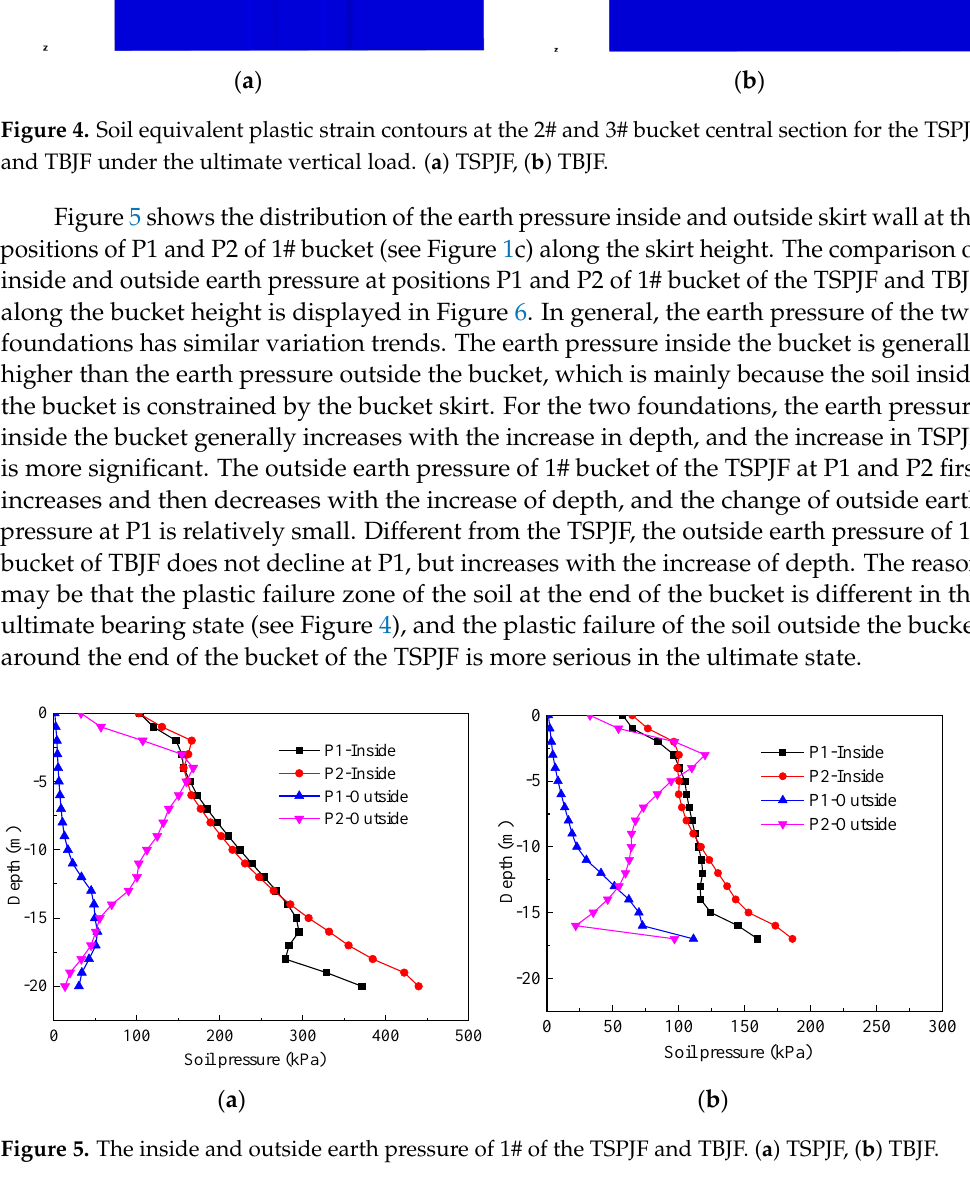
Figure 4. Soil equivalent plastic strain contours at the 2# and 3# bucket central section for the TSPJF and TBJF under the ultimate vertical load. ( a ) TSPJF, ( b ) TBJF.